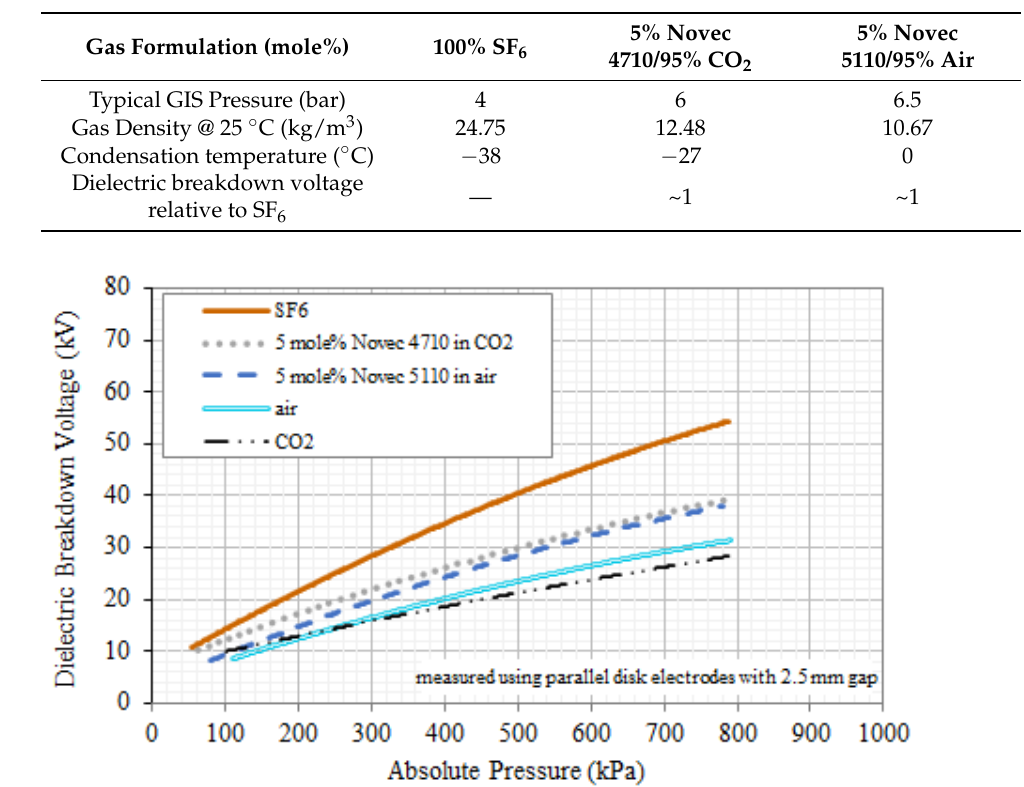
Figure 2. Variation in gas density as a function of gas column height. Gas mixtures are described in Table 2. Table 2. Gas mixture properties compared to SF 6 .